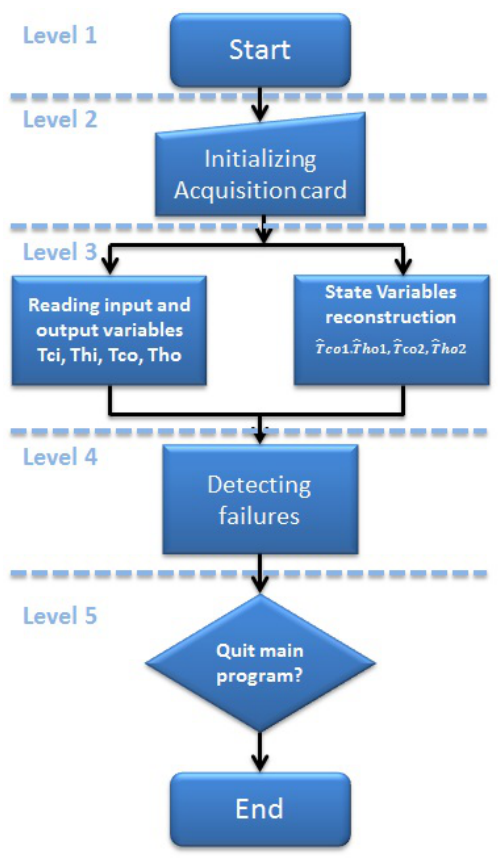
Figure 5. Hierarchic